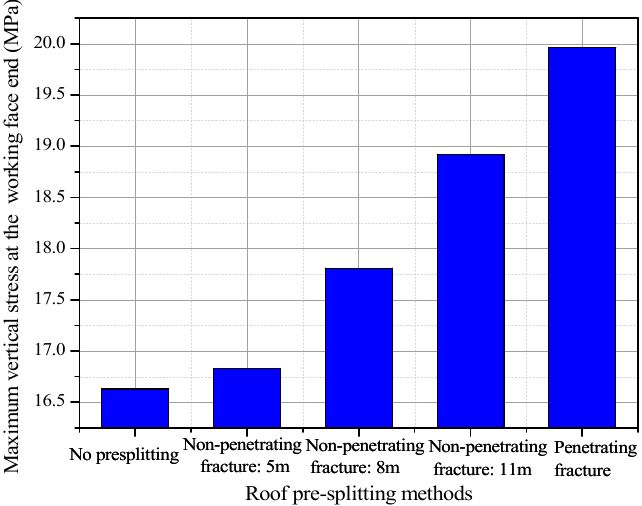
Figure 18. Stress distribution at the working face end with different roof cutting methods.